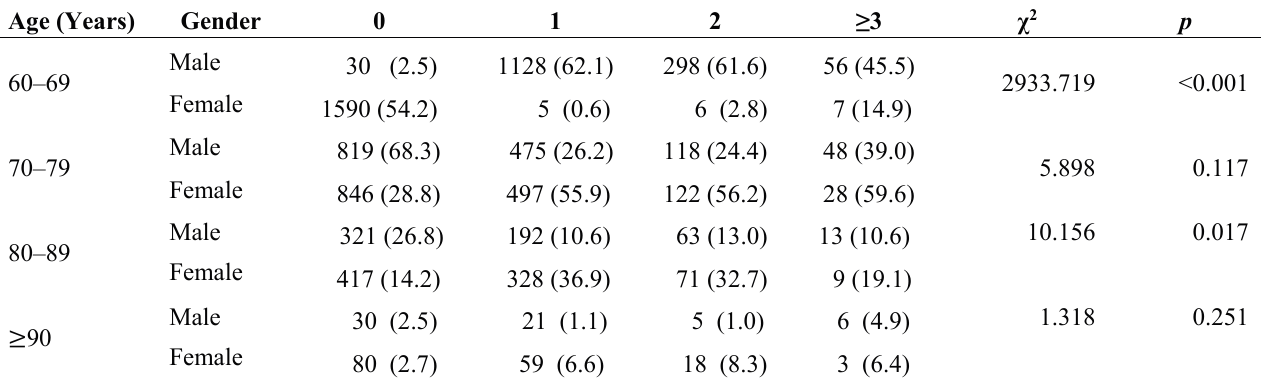
Table 3. Number of chronic conditions by age and gender ( n = number).